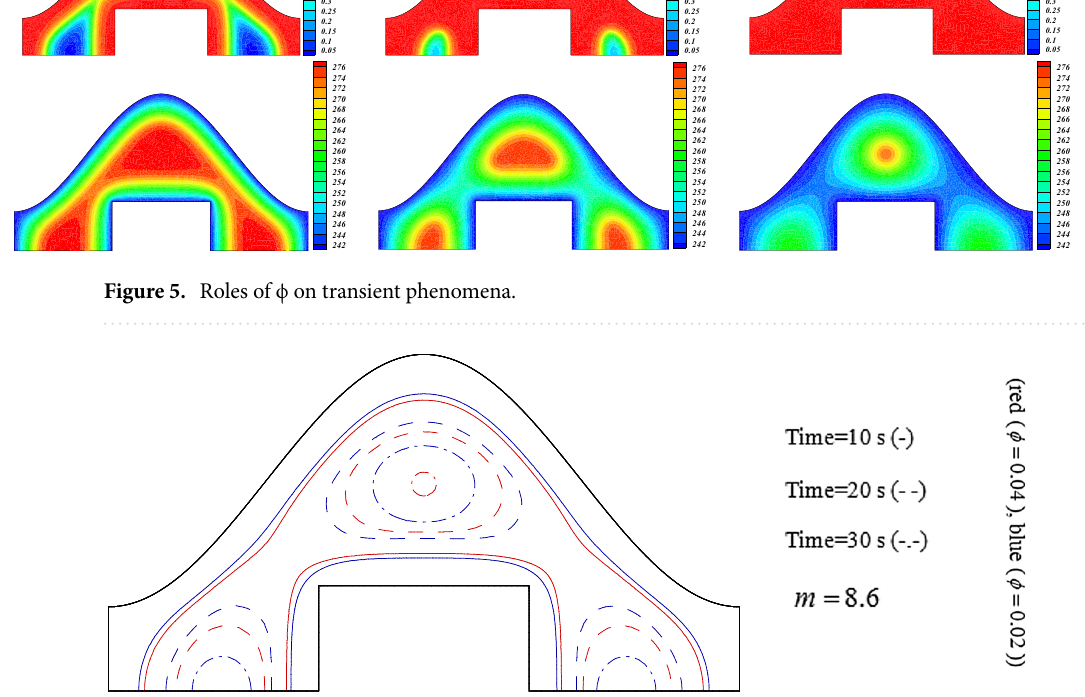
Figure 6. The role of ϕ on movement of ice